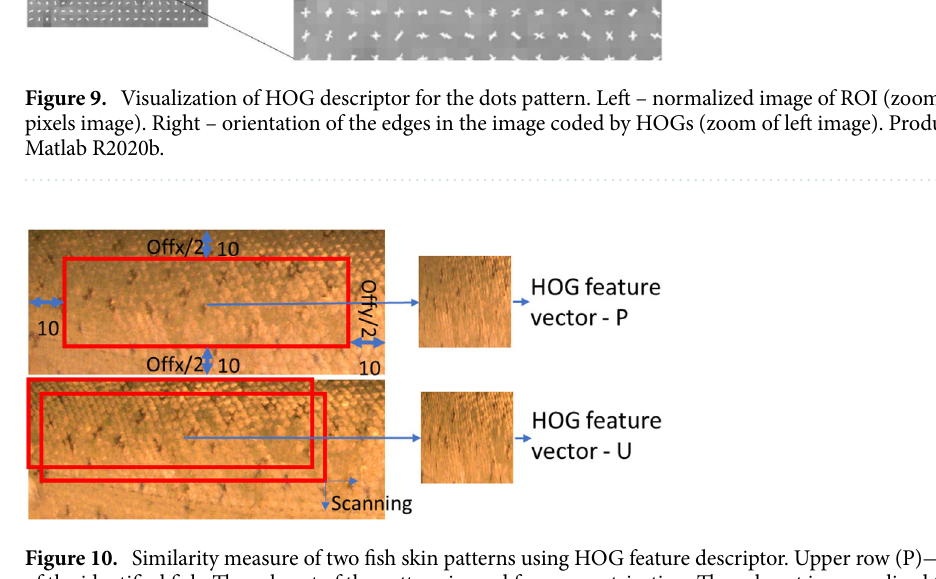
Figure 10. Similarity measure of two fish skin patterns using HOG feature descriptor. Upper row (P)—image of the identified fish. The subpart of the pattern is used for parametrization. The subpart is normalized to a 64 × 64 pixel image, and the HOG feature vector is calculated. Bottom row (U)—images of the unknown fish. The subpart of the pattern is selected from the image repeatedly by scanning over the image. The subpart is normalized to a 64 × 64 pixel image, and the HOG feature vector is calculated. The similarity between the P and U images is the best similarity between the P subset and one of the U subsets from the